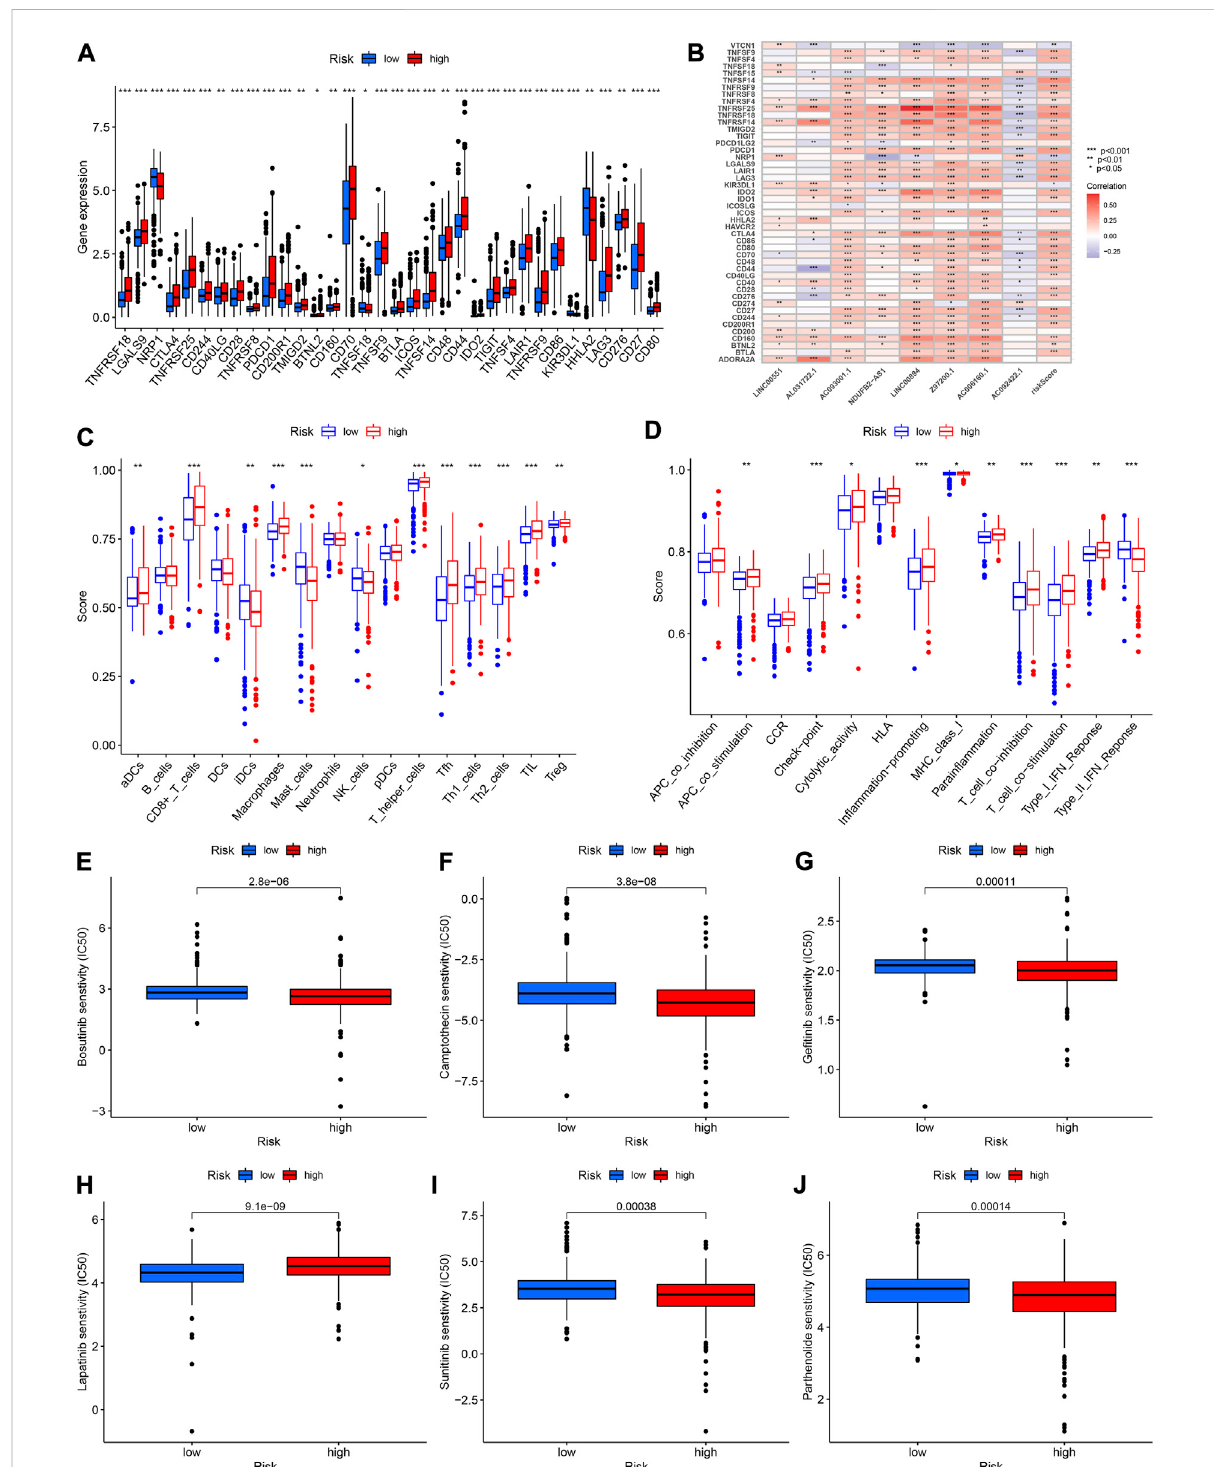
FIGURE 11 (A) Expressionofimmunecheckpointsinhigh-andlow-riskgroups. (B) RelationshipsbetweenimmunecheckpointandriskscoreandlncRNAs. (C,D) Comparison of the scores of immune cells and immune functions between high- and low-risk groups. (E – J) The abilities of the risk model to predict drug